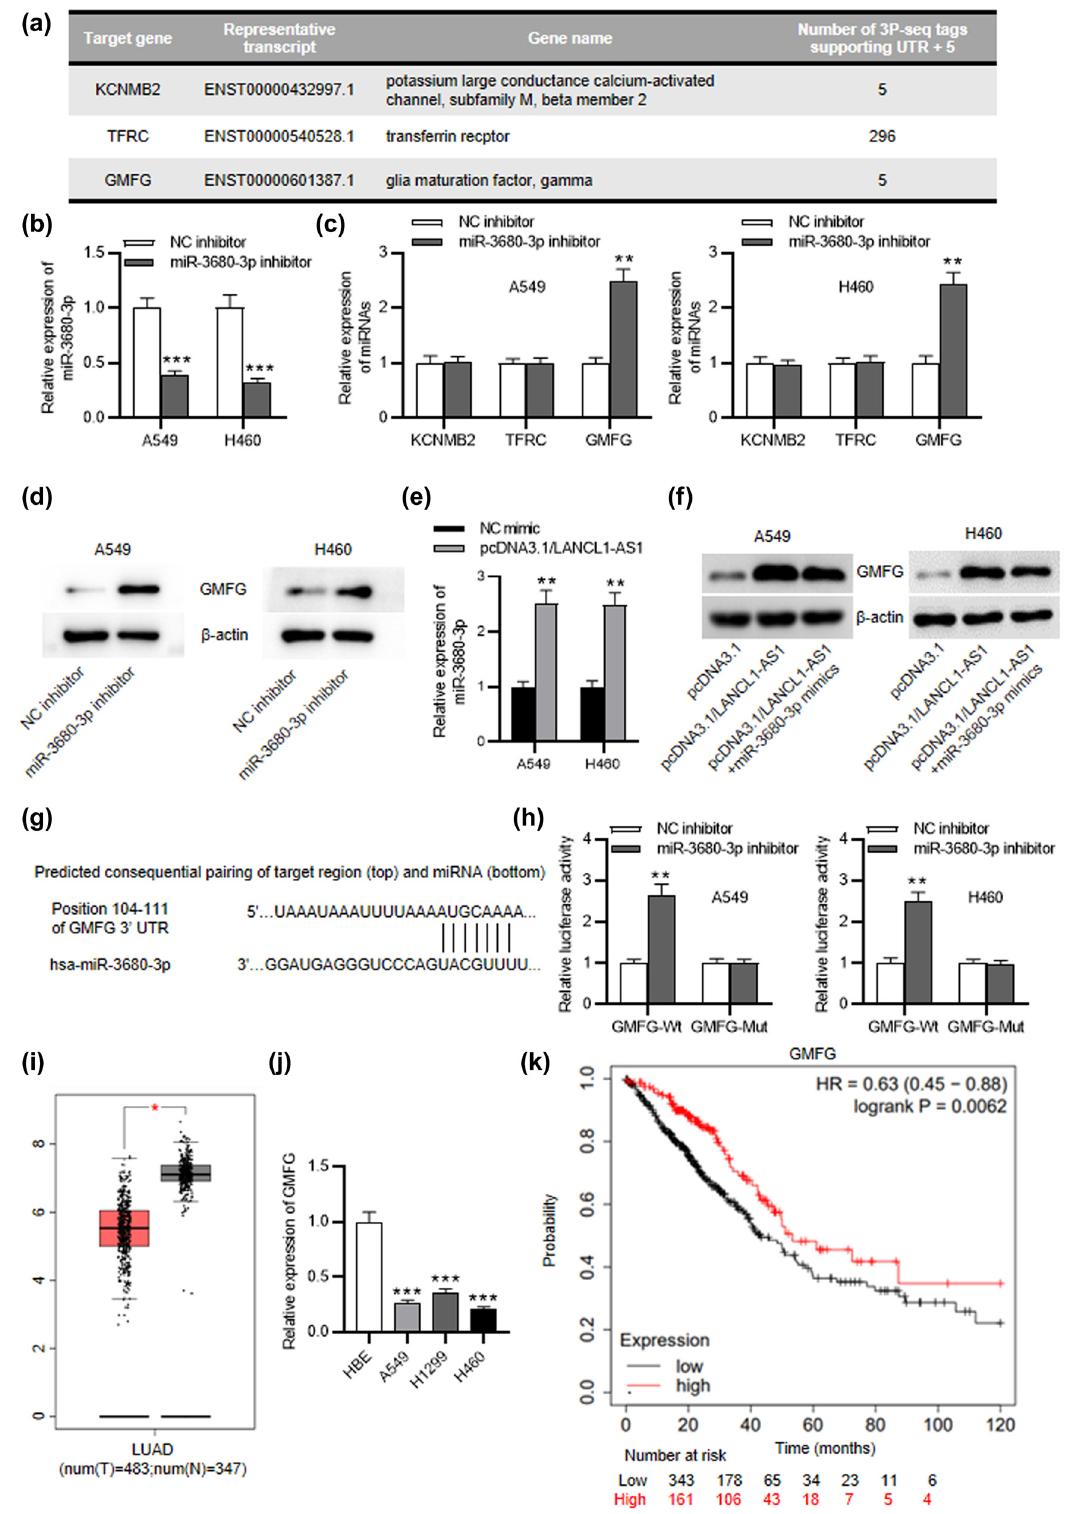
Figure 4: miR - 3680 - 3p targets GMFG. ( a ) TargetScan predicts three candidate downstream genes of miR - 3680 - 3p. ( b ) RT - qPCR for assessing miR - 3680 - 3p inhibitor transfection e ffi ciency. ( c ) RT - qPCR of mRNA expression in miR - 3680 - 30 - depleted NSCLC cells. ( d ) Western blotting of GMFG protein level in miR - 3680 - 3p - depleted NSCLC cells. ( e ) RT - qPCR for examining miR - 3680 - 3p overexpression e ffi ciency. ( f ) Western blotting of GMFG protein level in NSCLC cells with transfection of pcDNA3.1/LANCL1 - AS1 or pcDNA3.1/LANCL1 - AS1 + miR - 3680 - 3p mimics. ( g ) miR - 3680 - 3p complementary site on GMFG predicted by TargetScan. ( h ) The binding relation between miR - 3680 - 3p and GMFG identi fi ed by luciferase reporter assay. ( i ) GMFG expression in LUAD and normal tissues shown by GEPIA. ( j ) RT - qPCR of GMFG level in NSCLC and normal cell lines. ( k ) Kaplan – Meier plotter displays the association between GMFG expression and LUAD patient prognoses. * p < 0.05, ** p < 0.01, *** p <